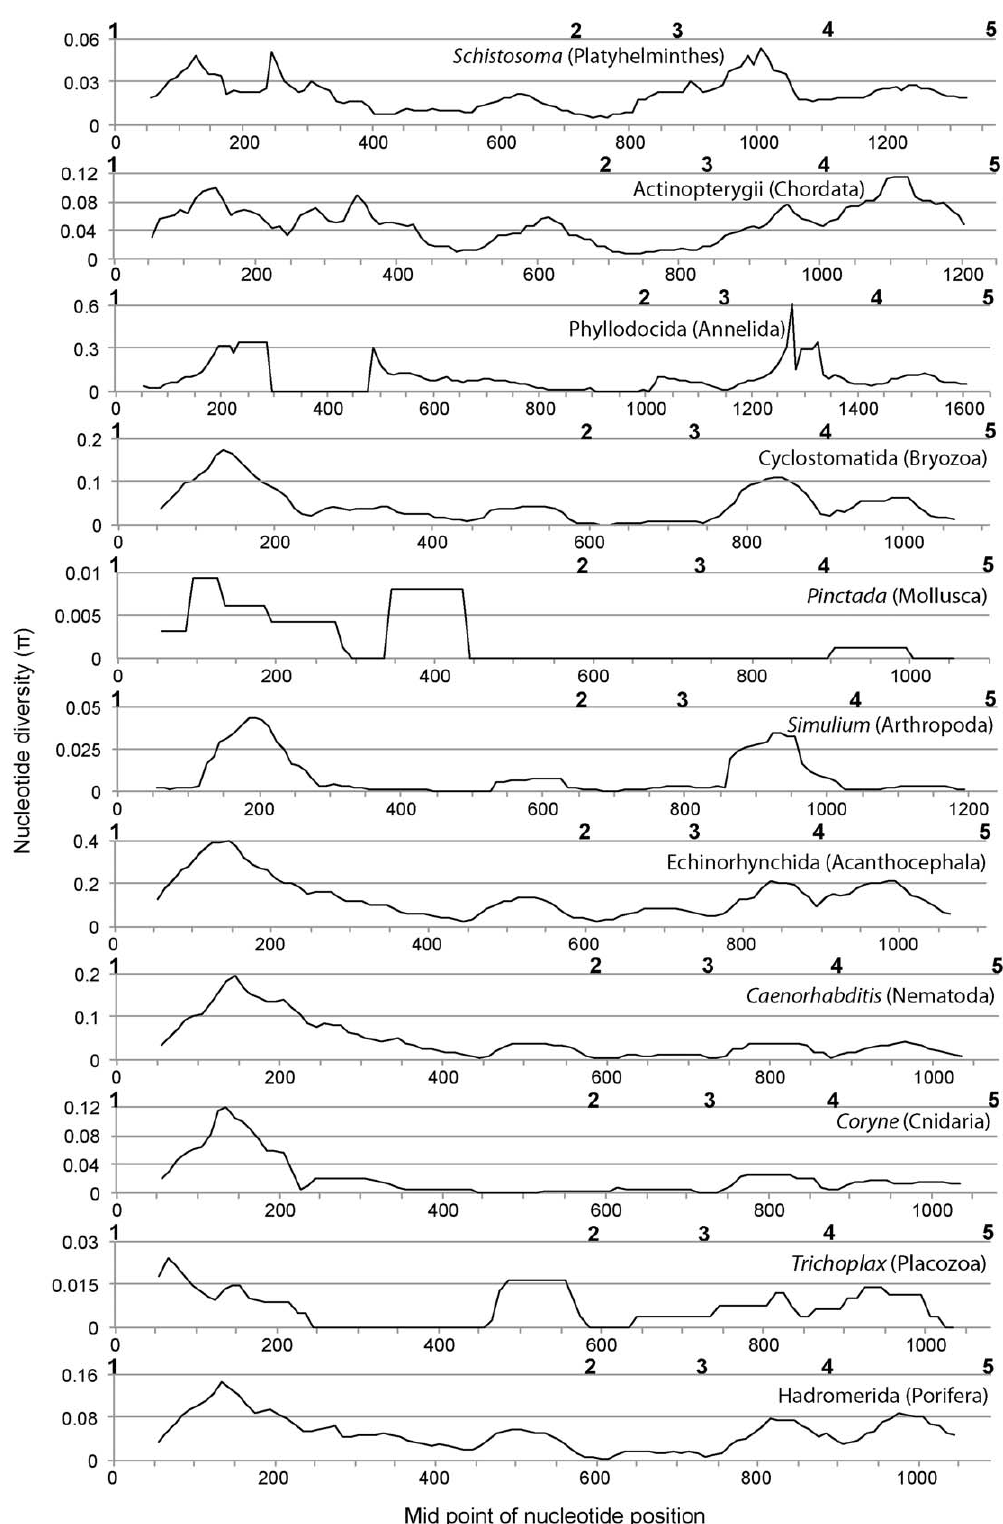
Figure 2. Sliding-window plots of nucleotide diversity ( p ) across the nuclear 18S ribosomal DNA of the 11 selected taxa. Positions of the newly designed primers are indicated above the X-axis in bold. Phylum of each taxonomic group is indicated in parentheses. The analyses were performed using sequences of 101 Schistosoma (Platyhelminthes), 257 Actinopterygii (Chordata), 214 Phyllodocida (Annelida), 20 Cyclostomatida (Bryozoa), 17 Pinctada (Mollusca), 27 Simulium (Arthropoda), 19 Echinorhynchida (Acanthocephala), 20 Caenorhabditis (Nematoda), 12 Coryne (Cnidaria), 9 Trichoplax (Placozoa), and 12 Hadromerida (Porifera).